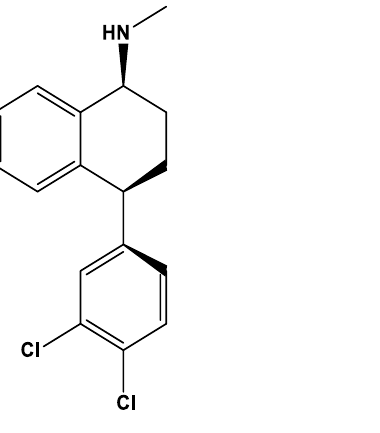
Figure 1. Chemical structure of sertraline. The structure was obtained using ChemDraw software (version 12.0, PerkinElmer, Inc. Waltham, MA, USA).